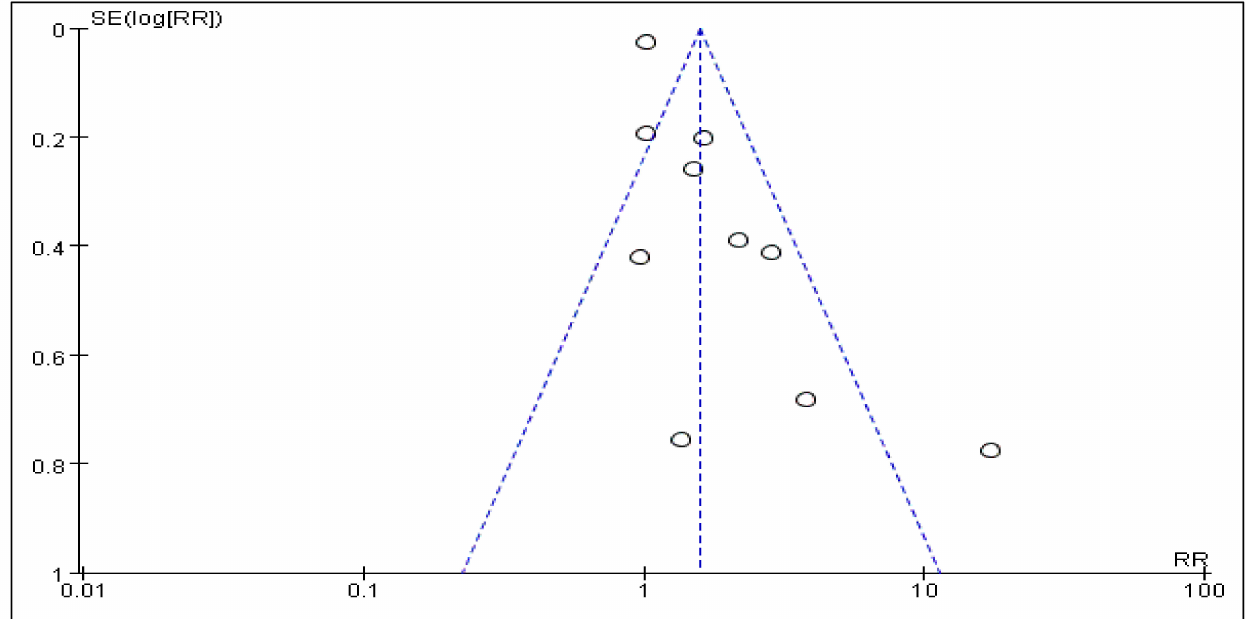
Figure 6. Diagnosis of the NEs. The results were stratified by the diagnosis of the NEs [43–51].